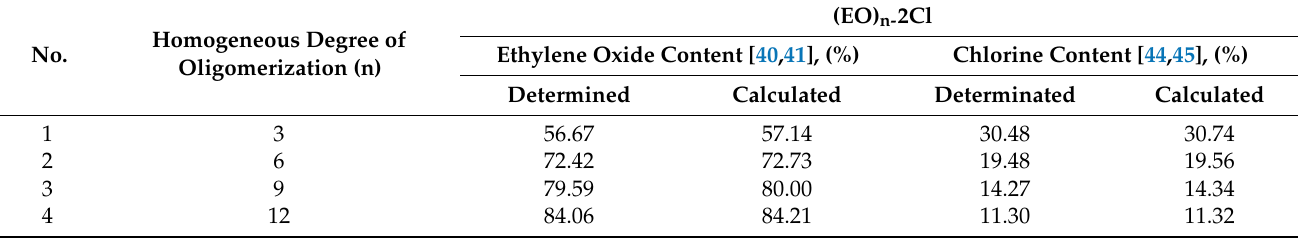
Table 12. The main chemical characteristics of dichlorinated homogeneous polyoxyethylene (n = 3, 6, 9, 12) chains (EO) n - 2Cl. Homogeneous Degree No.